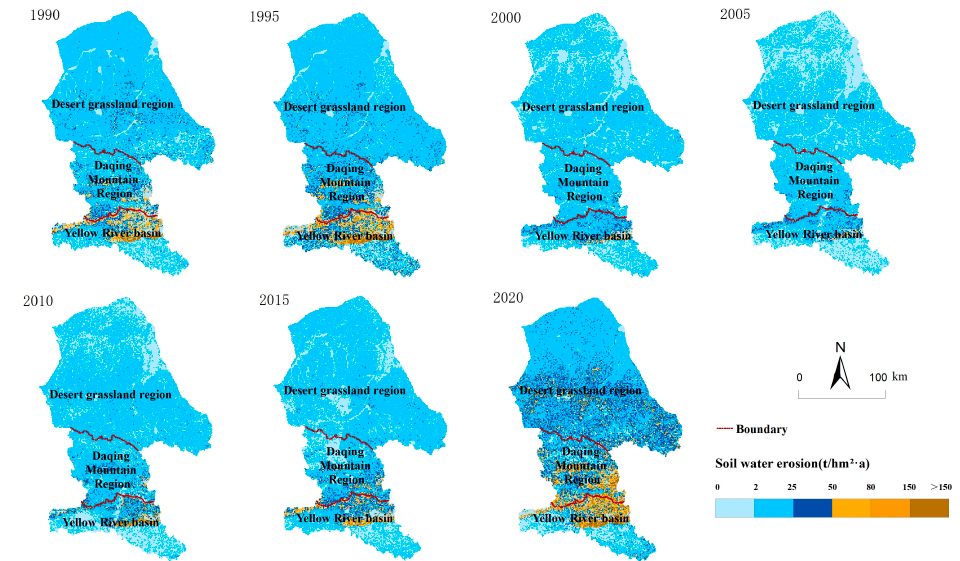
Figure 5. Spatial distribution of soil water erosion in Baotou City.